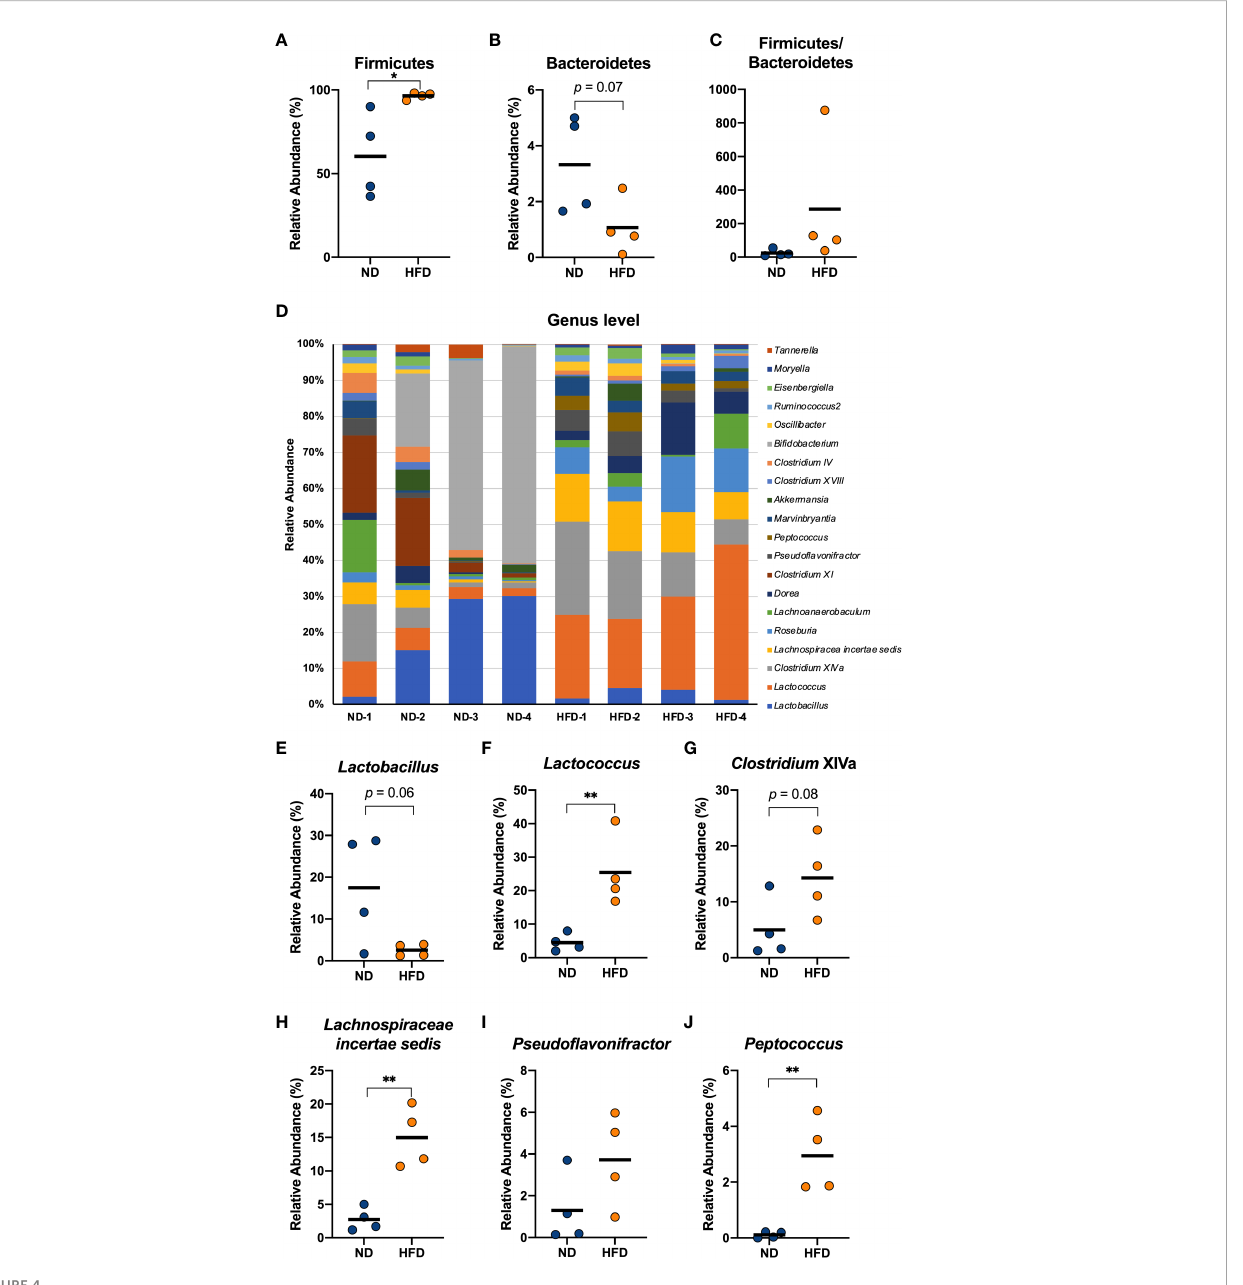
FIGURE 4 Four weeks of intake of a HFD caused signi fi cant changes in several genera derived from the cecum of mice. Male C57Bl/6N mice fed a HFD for 4 weeks were compared with mice fed a normal diet. The cecal contents of the mice were isolated, and the gut microbiota was investigated with next- generation sequencing applications. At the phylum level, the relative abundance of Firmicutes (A) and Bacteroidetes (B) and the ratio of the two (C) were calculated. At the genus level, the composition of the gut microbiota of each mouse was analysed and compared (D) . The relative abundance of Lactobacillus (E) , Lactococcus (F) , Clostridium XIVa (G) , Lachnospiraceae incertae sedis (H) , Pseudo fl avonifractor (I) , and Peptococcus (J) in the HFD group were calculated and compared with those in the ND group. The results are representative of two independent experiments and are shown as the mean ± standard deviation (n = 6). * p <0.05; ** p <0.01 (assessed using Student ’ s t -test). ND, normal diet; HFD, high-fat